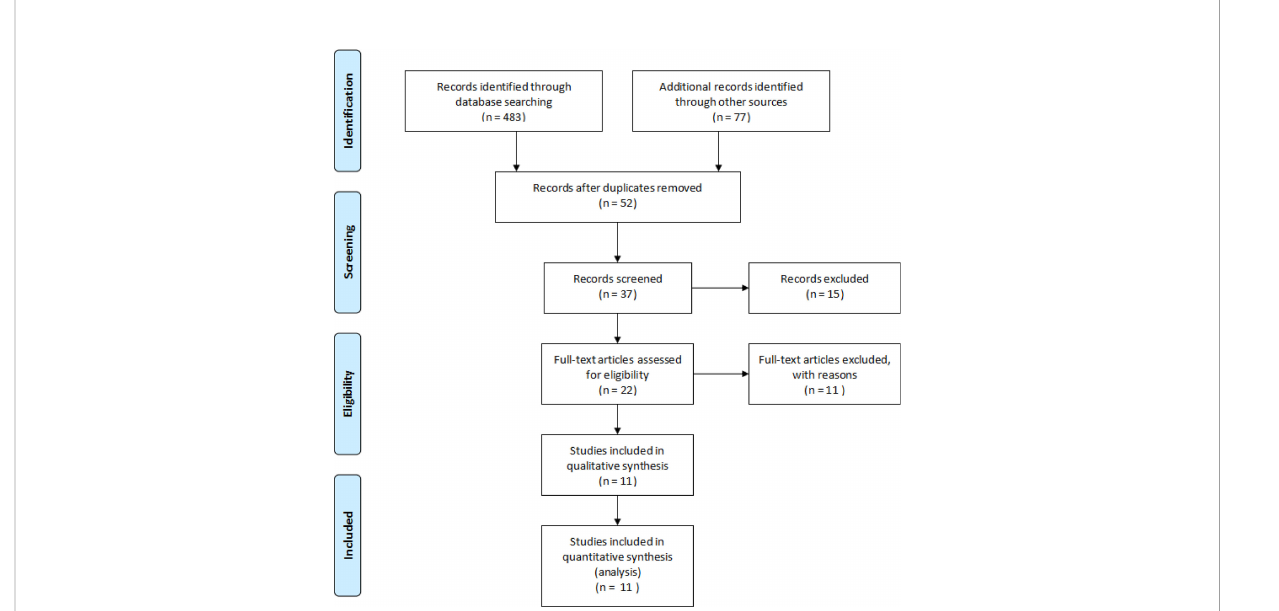
FIGURE 1 Preferred reporting items for the systematic review and meta-analysis study fl ow diagram for the literature